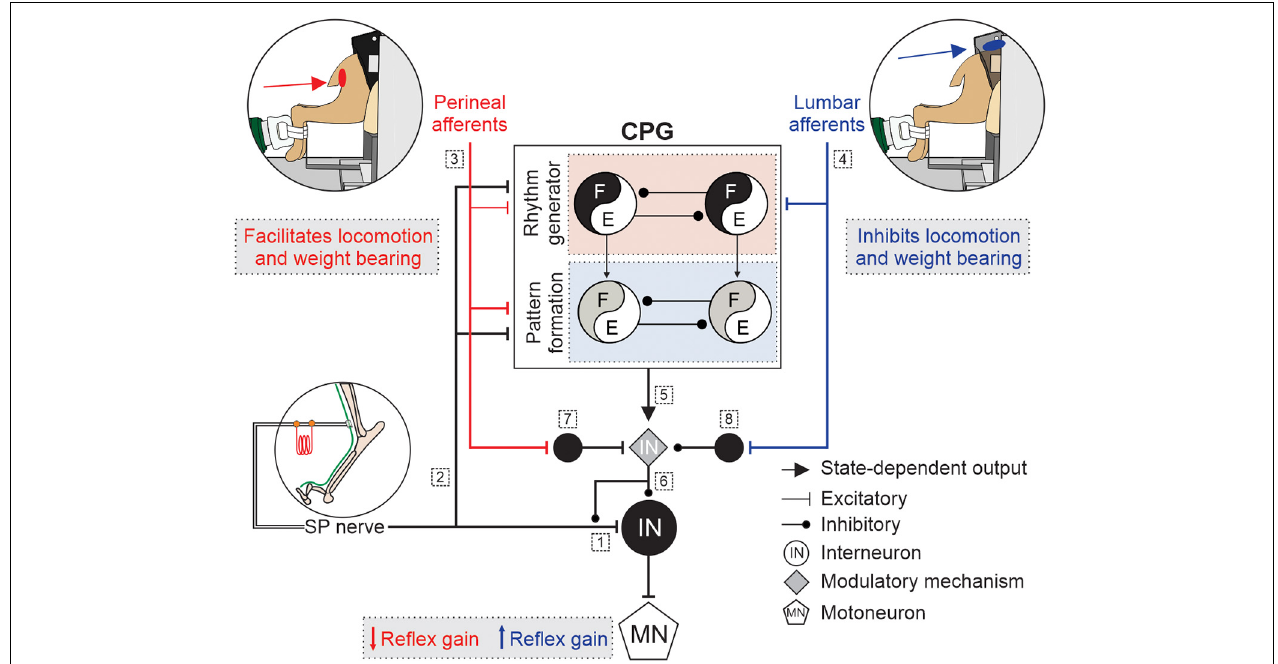
FIGURE 2 | Schematic illustration of potential mechanisms modulating hindlimb locomotion and cutaneous reflexes with lumbar or perineal stimulation. Some potential mechanisms involved in the modulation of hindlimb locomotion and cutaneous reflexes, evoked by superficial peroneal (SP) nerve stimulation, with lumbar (blue) or perineal stimulation (red) are illustrated. Afferents from the SP nerve project to (1) spinal neurons and elicit reflex responses and to (2) a two-level central pattern generator (CPG) that includes rhythm generation (RG), and pattern formation (PF) levels. (3) Inputs from the perineal region primarily affect the PF level with weaker effects on the RG whereas (4) inputs from the lumbar region directly access the RG level. (5) The state of the spinal locomotor CPG controls the modulatory mechanism. (6) The modulatory mechanism controls neurotransmitter release of primary afferents from the SP nerve and the excitability of neurons within the reflex pathway. Inputs from the (7) perineal or (8) lumbar region projects to neurons that regulate the excitability of the modulatory mechanism. E, extensors; F, flexors; IN, interneurons; MN,